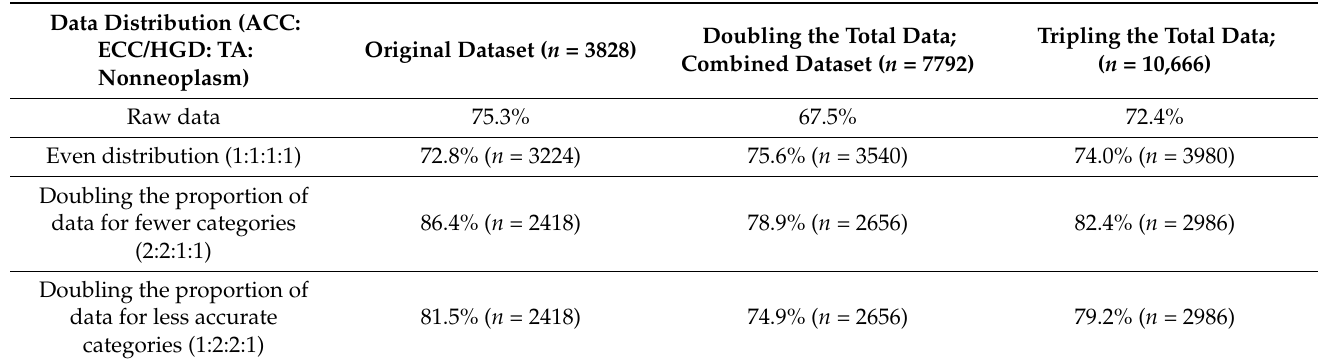
Table 3. Internal-test accuracy according to each data volume and class distribution.